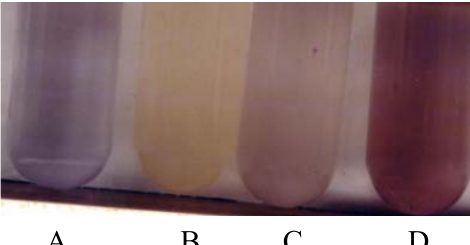
Figure 1. Detection of M. neoaurum exochelin in spent supernatants of M. neoaurum grown in iron-deficiency, zinc-deficiency and iron-sufficiency.